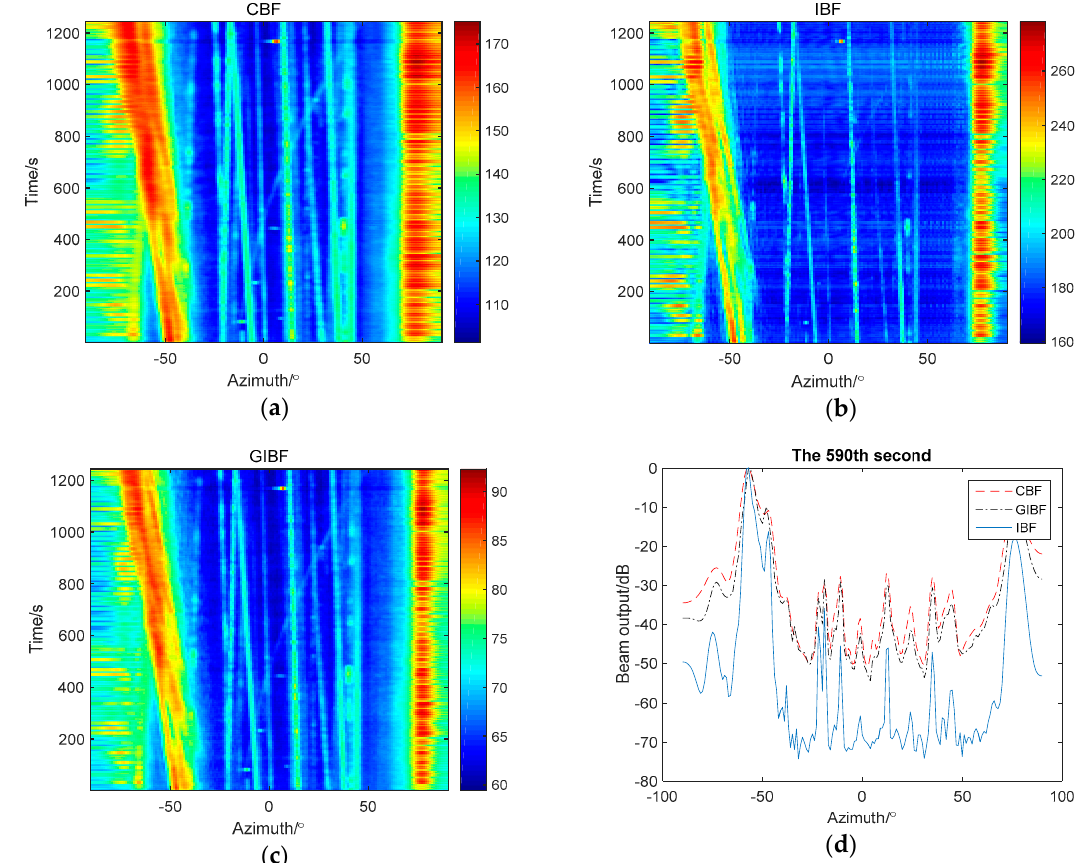
Figure 7. The comparison between three methods: ( a ) azimuth history diagram by CBF; ( b ) azimuth history diagram by IBF; ( c ) azimuth history diagram by GIBF; ( d ) beam pattern of three methods in 590th s.